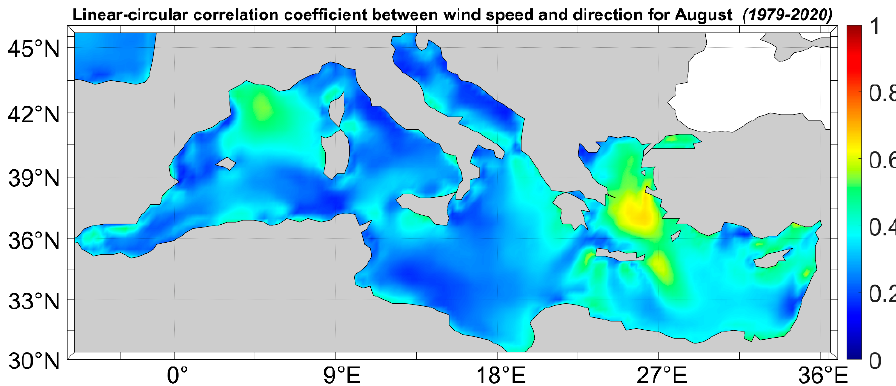
Figure 15. Linear-circular correlation coefficient of wind speed and direction for August.